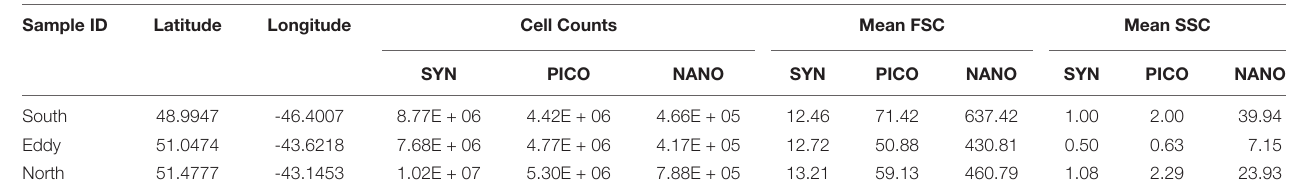
TABLE 1 | Cell counts, forward scatter (FSC) and side scatter (SSC) properties measured from the ICS for Synechococcus spp. (SYN), picoeukaryotes (PICO) and nanoeukaryotes